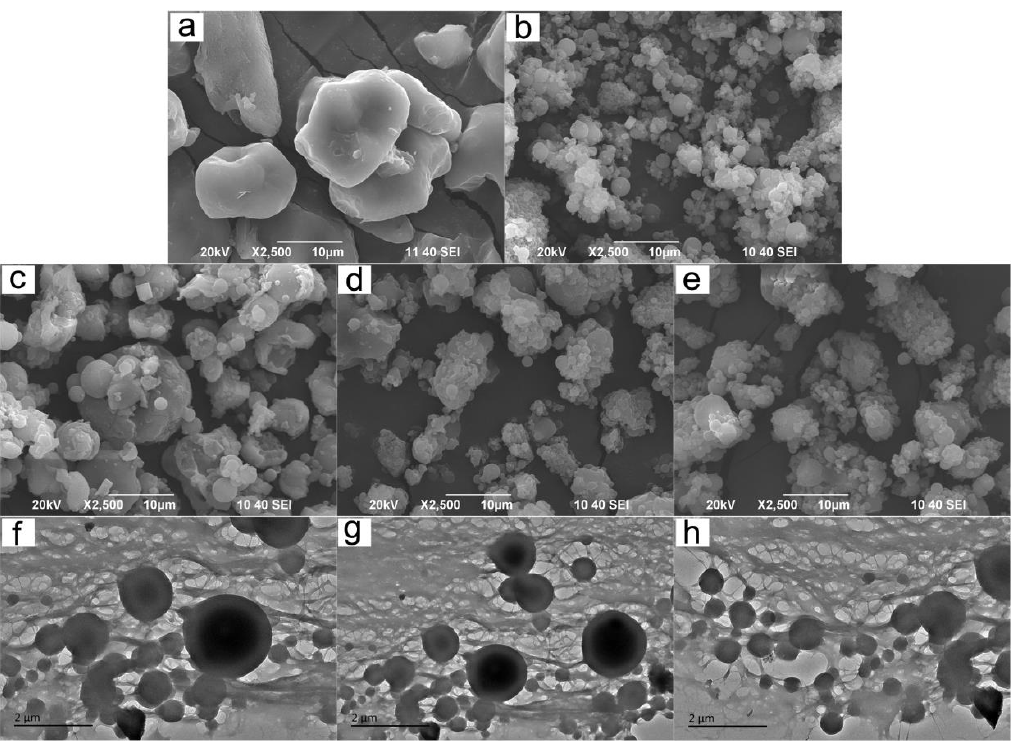
Figure 5. SEM images of ( a ) CCS, ( b ) CCP, ( c ) CCSP1, ( d ) CCSP2, and ( e ) CCSP with a mass ratio of CS/CP of 1:2 (CCSP3). TEM images of ( f ) CCSP1, ( g ) CCSP2, and ( h ) CCSP3.